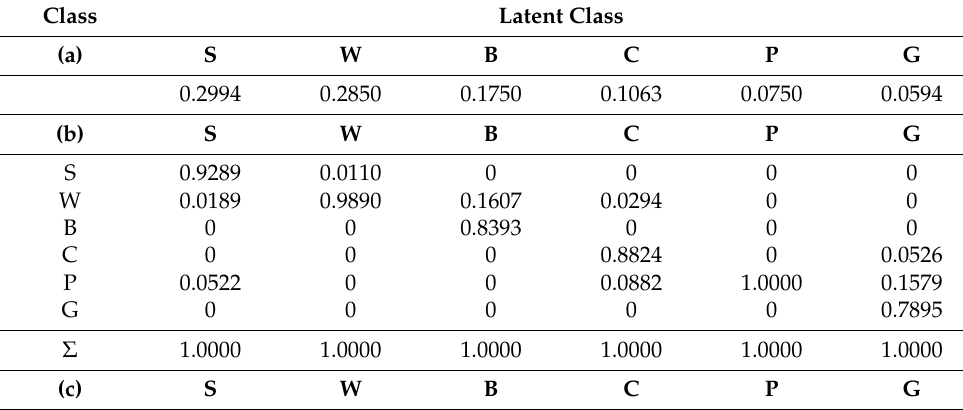
Table 1. Probabilities output from the latent class analysis of the ATM data set. ( a ) latent class probabilities (i.e., π X x ), ( b ) conditional probabilities from the discriminant analysis, ( c ) conditional probabilities from the decision tree, ( d ) conditional probabilities from the neural network and ( e ) conditional probabilities from the support vector machine. Note that class membership in the latent variable is shown in columns and the elements on the main diagonal in ( b – e ) represents the producer’s